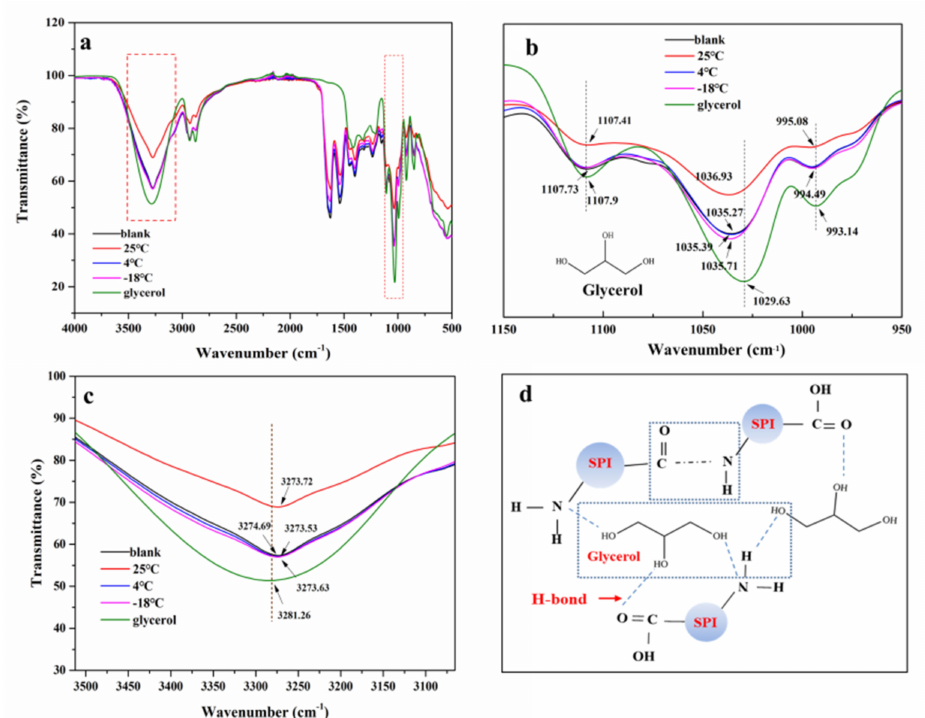
Figure 5. Attenuated total reflection infrared spectroscopy (ATR-FTIR) of SPI edible films before (blank) and after storage by 6 weeks at different temperatures (( a ) 500–4000 cm − 1 ; ( b ) 950–1150 cm − 1 ; ( c ) 3000–3510 cm − 1 ; ( d ) Molecular interaction between glycerol and soy protein